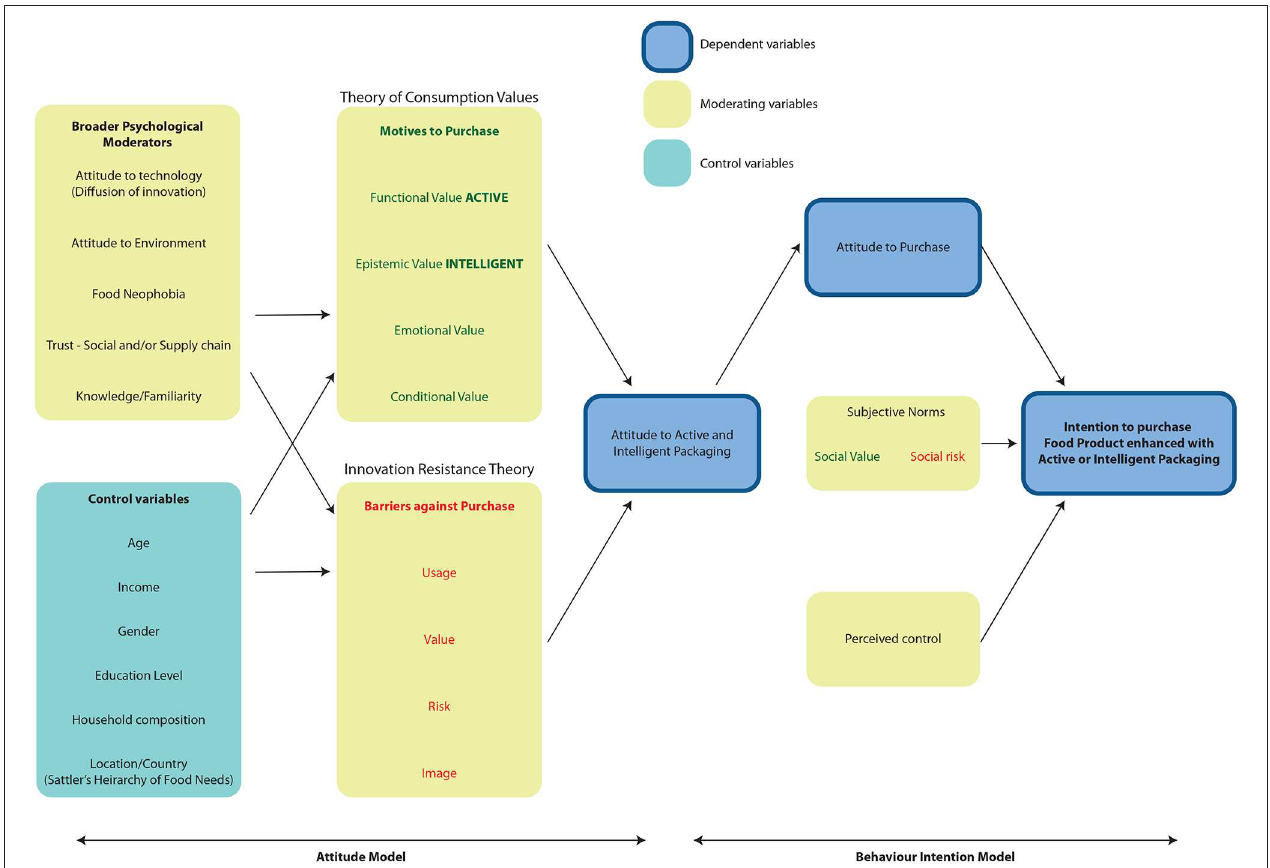
FIGURE 8 | Final conceptual framework on drivers of acceptance of smart packaging.